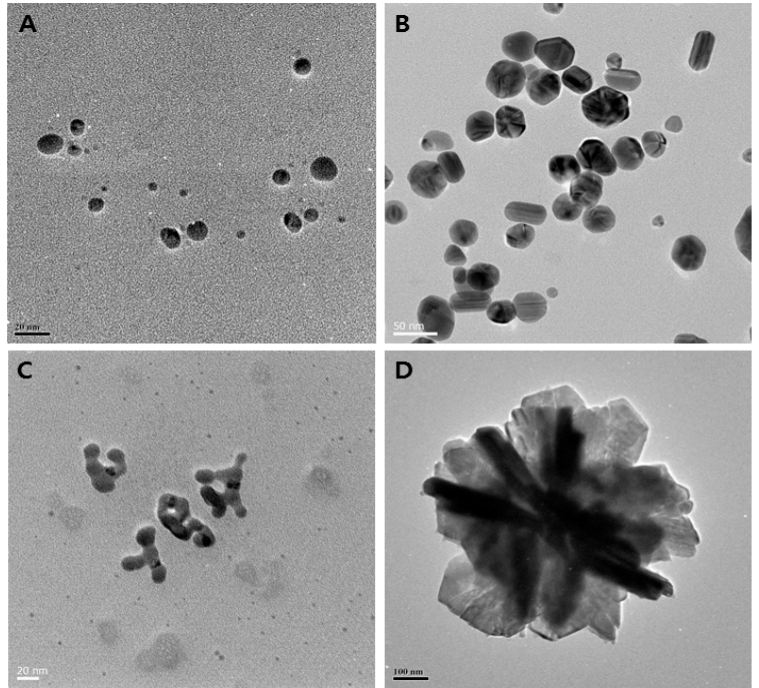
Figure 2. Biological synthesis of various shapes of AgNPs using culture supernatant of various Bacillus species. ( A ) Spherical; ( B ) mixed populations (octagonal, rod, hexagonal, and icosahedral); ( C ) highly branched; ( D ) flower-like in shape.